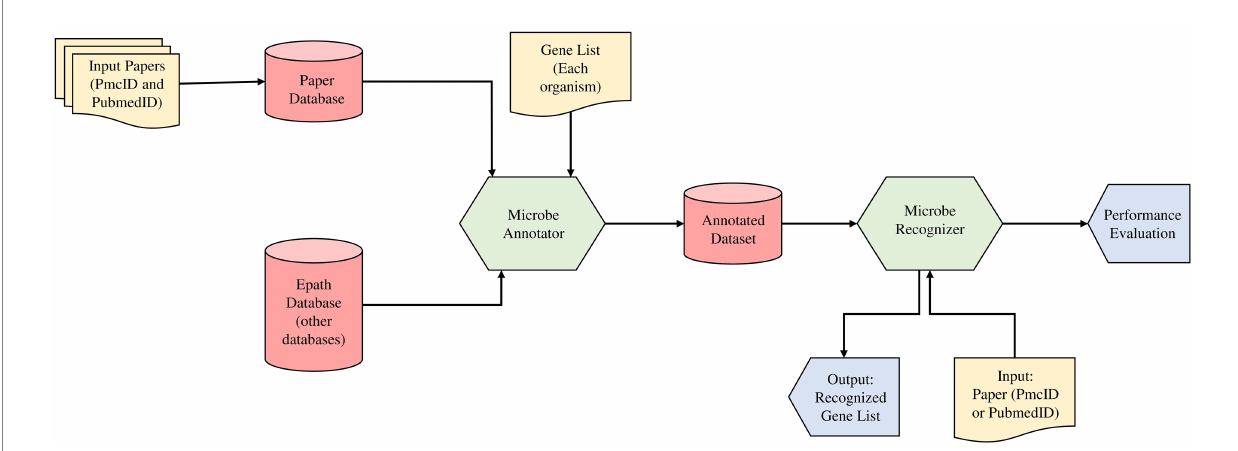
FIGURE 1 The text mining method based on Name Entity Recognition principle (NER) state of the art machine learning model. The study incorporated two modules (Microbe annotator and Microbe recognizer) in the predictive model for the gene prediction and feature analysis from literature databases and EPATH databases,